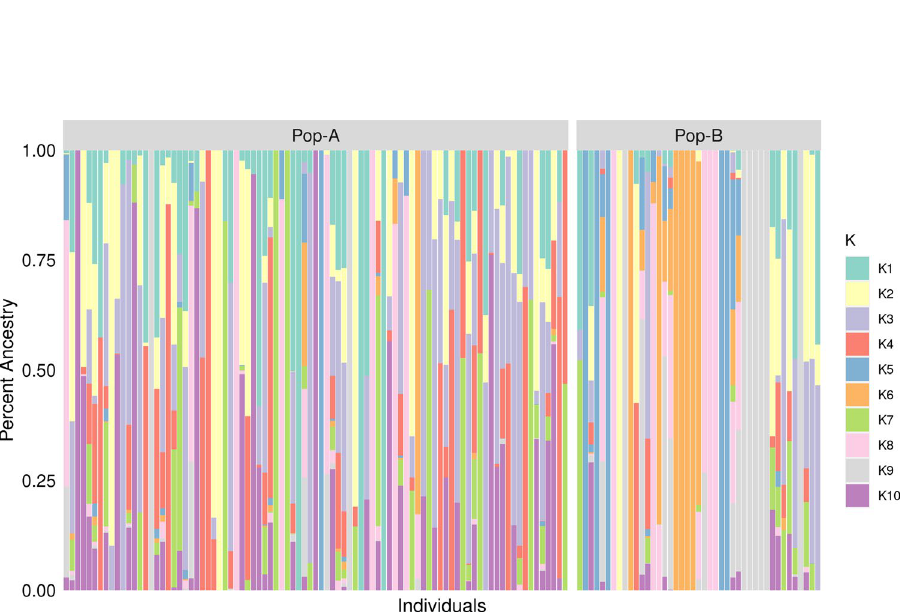
Figure 3. Individual assignment probabilities generated with ADMIXTURE (K = 10). Each color represents a cluster, and the ratio of vertical lines is proportional to assignment probability of an individual to each